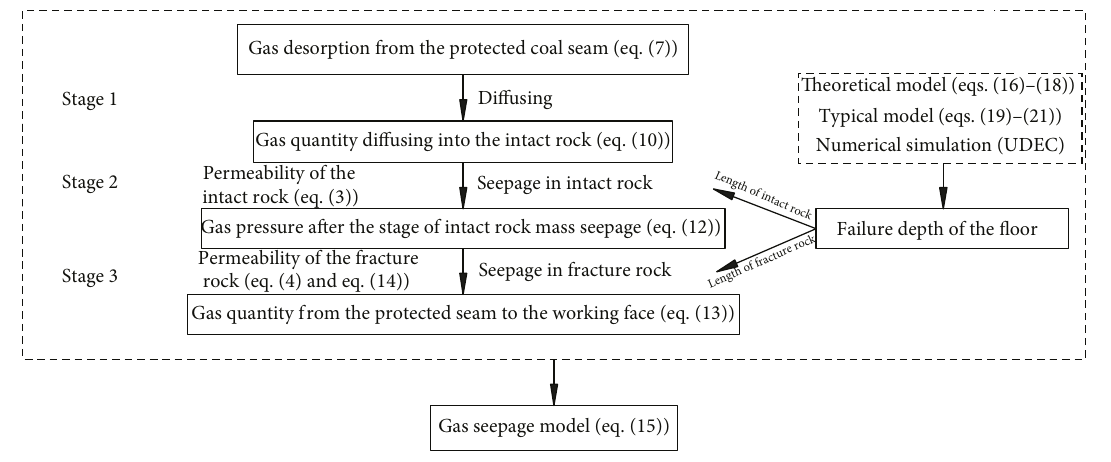
Figure 10: Calculation process of the gas seepage